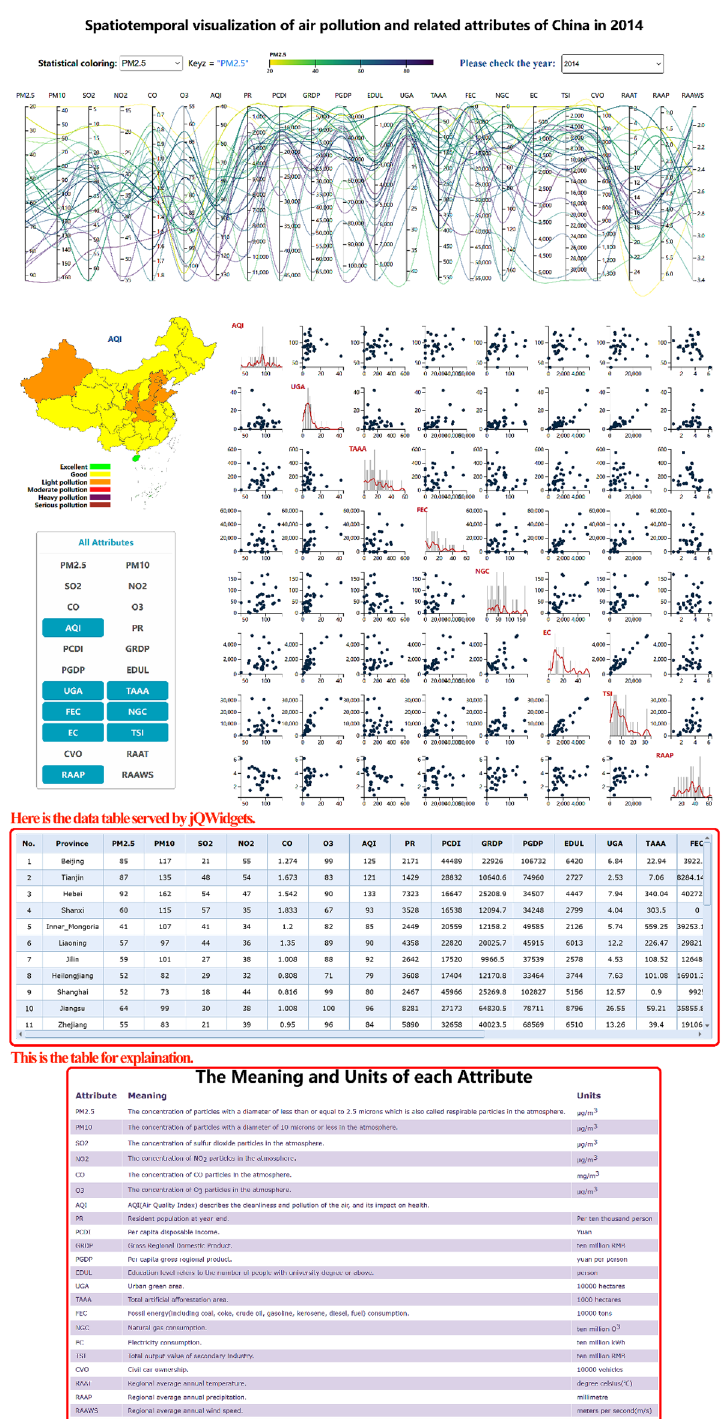
Figure 6. Comprehensive visualization of the high-dimensional spatiotemporal air quality dataset. PCPs, maps, customized scatterplot matrices, and assisted tables are integrated. It is easy to visually analyze spatiotemporal datasets from various fields through interactive analysis